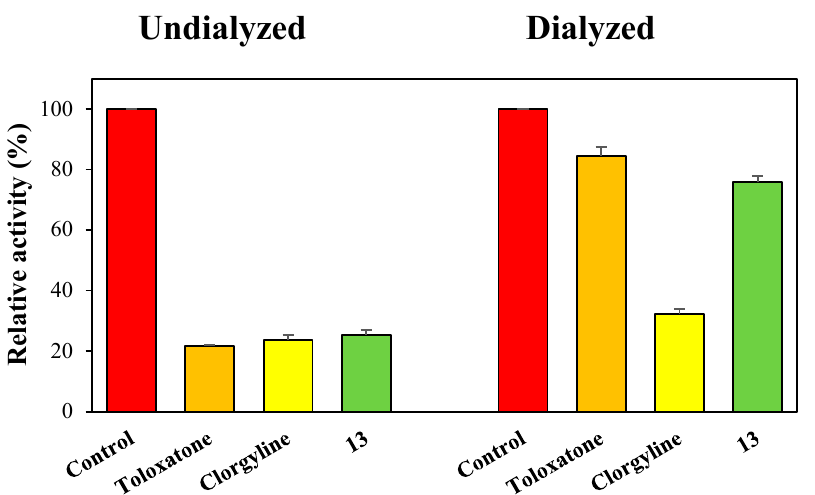
Figure 3. Recovery of hMAO-A inhibition by 13 after dialysis. Toloxatone and clorgyline were used as reference reversible and irreversible MAO-A inhibitors, respectively. The concentrations of the inhibitors used were as follows: 13 , 3.0 µ M; toloxatone, 2.16 µ M; and clorgyline, 0.014 µ M. Results are the averages of experiments performed in duplicate.